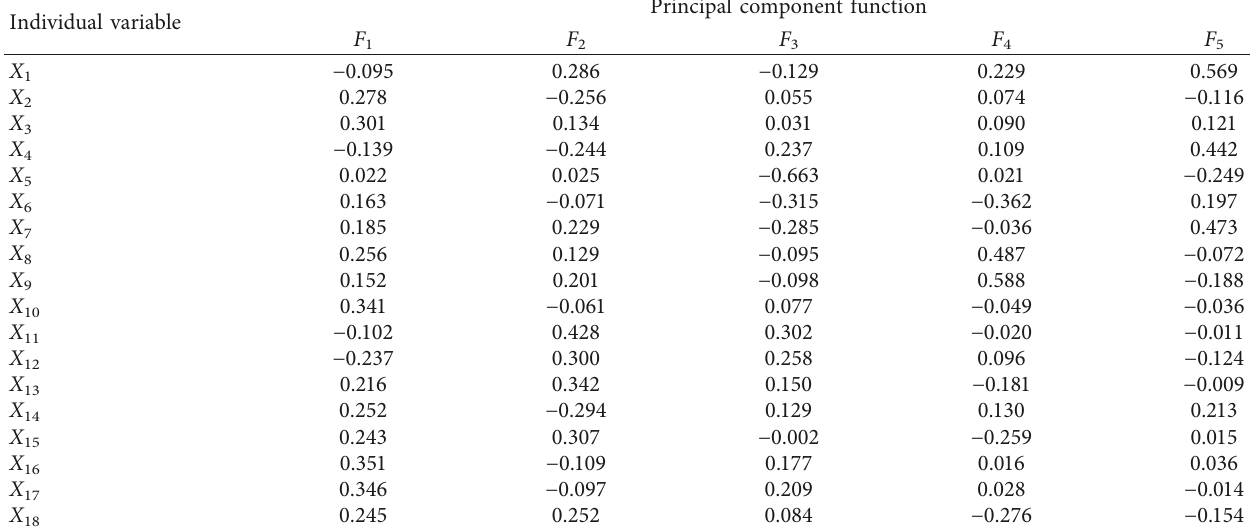
Table 5: Eigenvector of primary components.